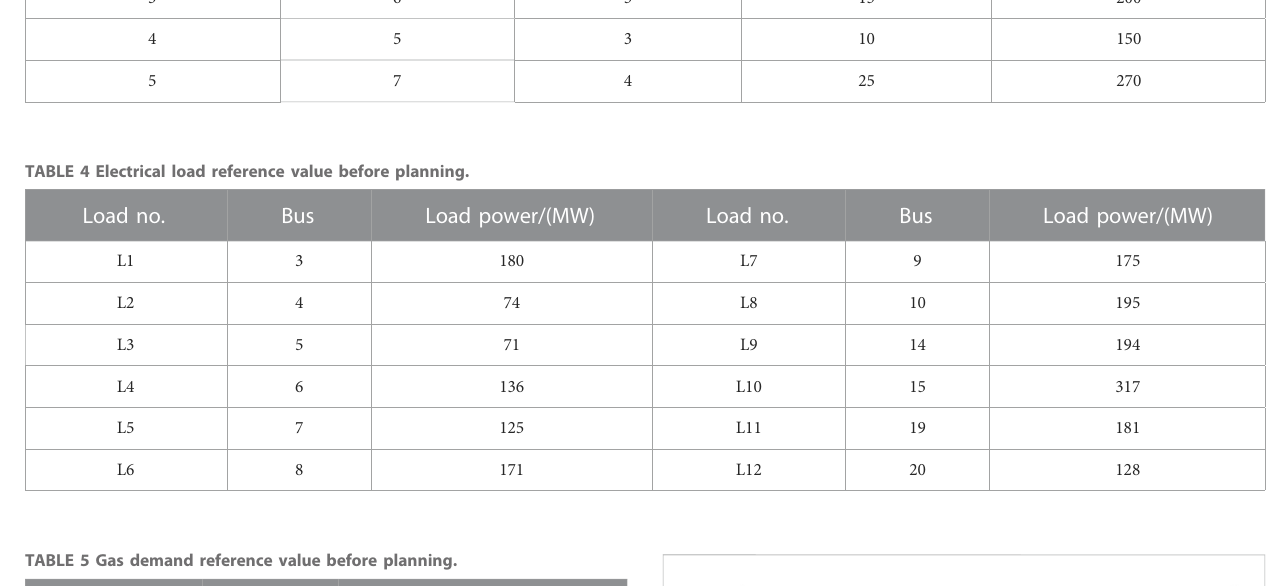
TABLE 5 Gas demand reference value before planning. Load no.